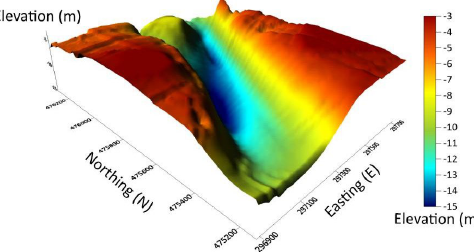
Figure 8. Bathymetric plan in 3D